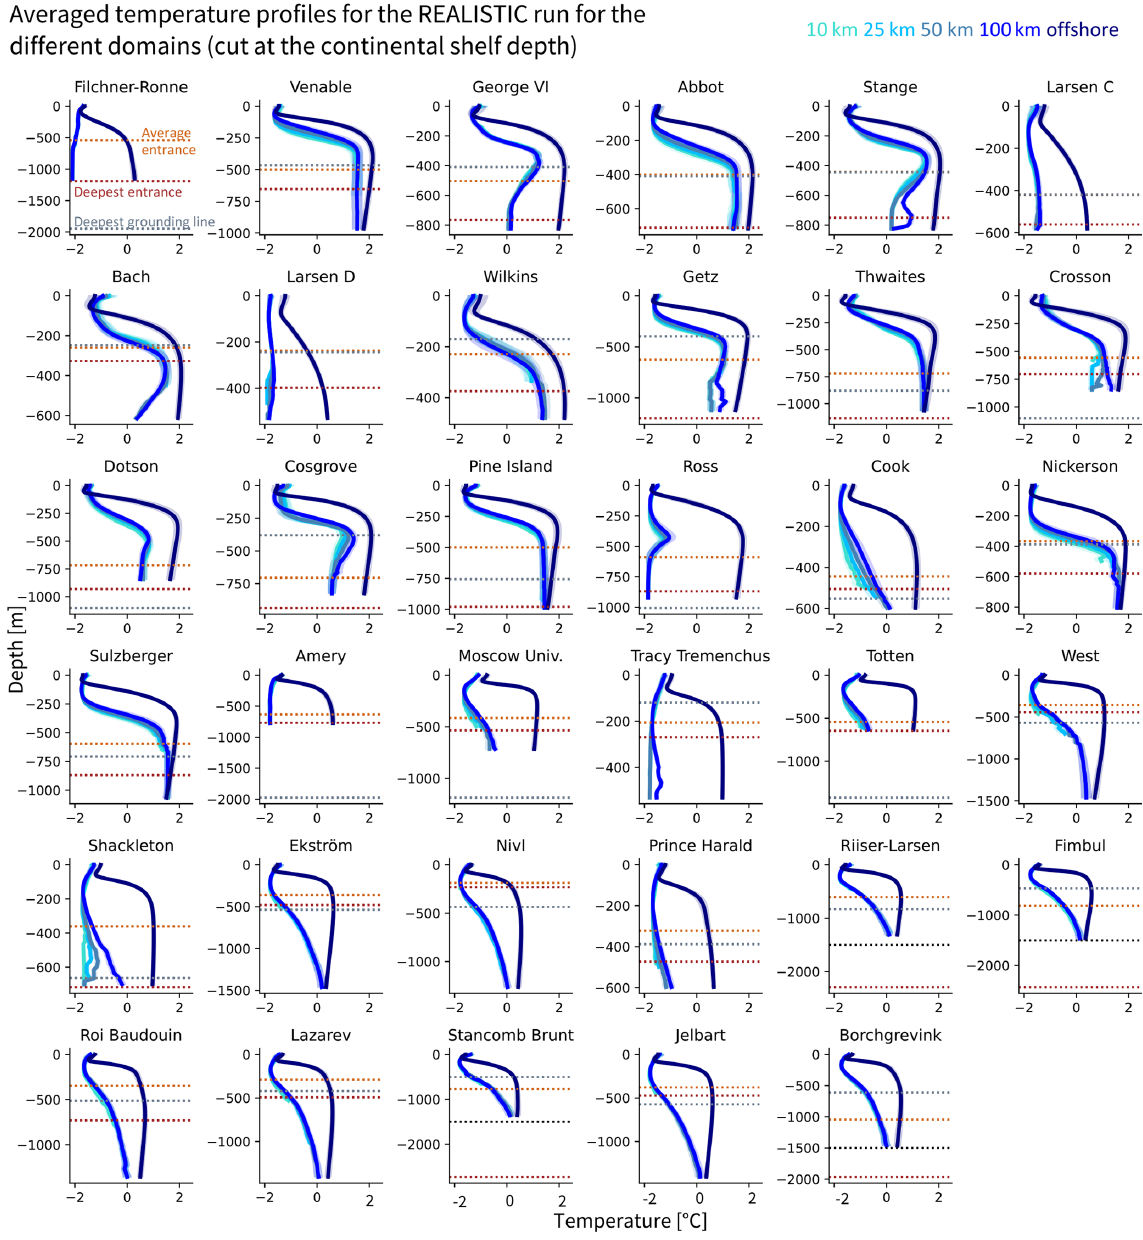
Figure 3. Comparison of mean input temperature profiles between the five different domains which were averaged (10, 25, 50, 100km, and offshore) in one given simulation (REALISTIC). The shading represents the interannual variability (1 standard deviation over time). The horizontal dotted lines show the average depth of the bed at the ice front (light brown), the largest depth of the bed at the ice front (dark brown), and the largest depth of the grounding line (grey). For a few ice shelves, the deepest entrance is deeper than 1500m depth, but the profiles are defined over the continental shelf (depth shallower than − 1500m). A black dotted line denotes the 1500m limit in this case. For Stange and Larsen C ice shelves, the average entrance depth and the deepest grounding line